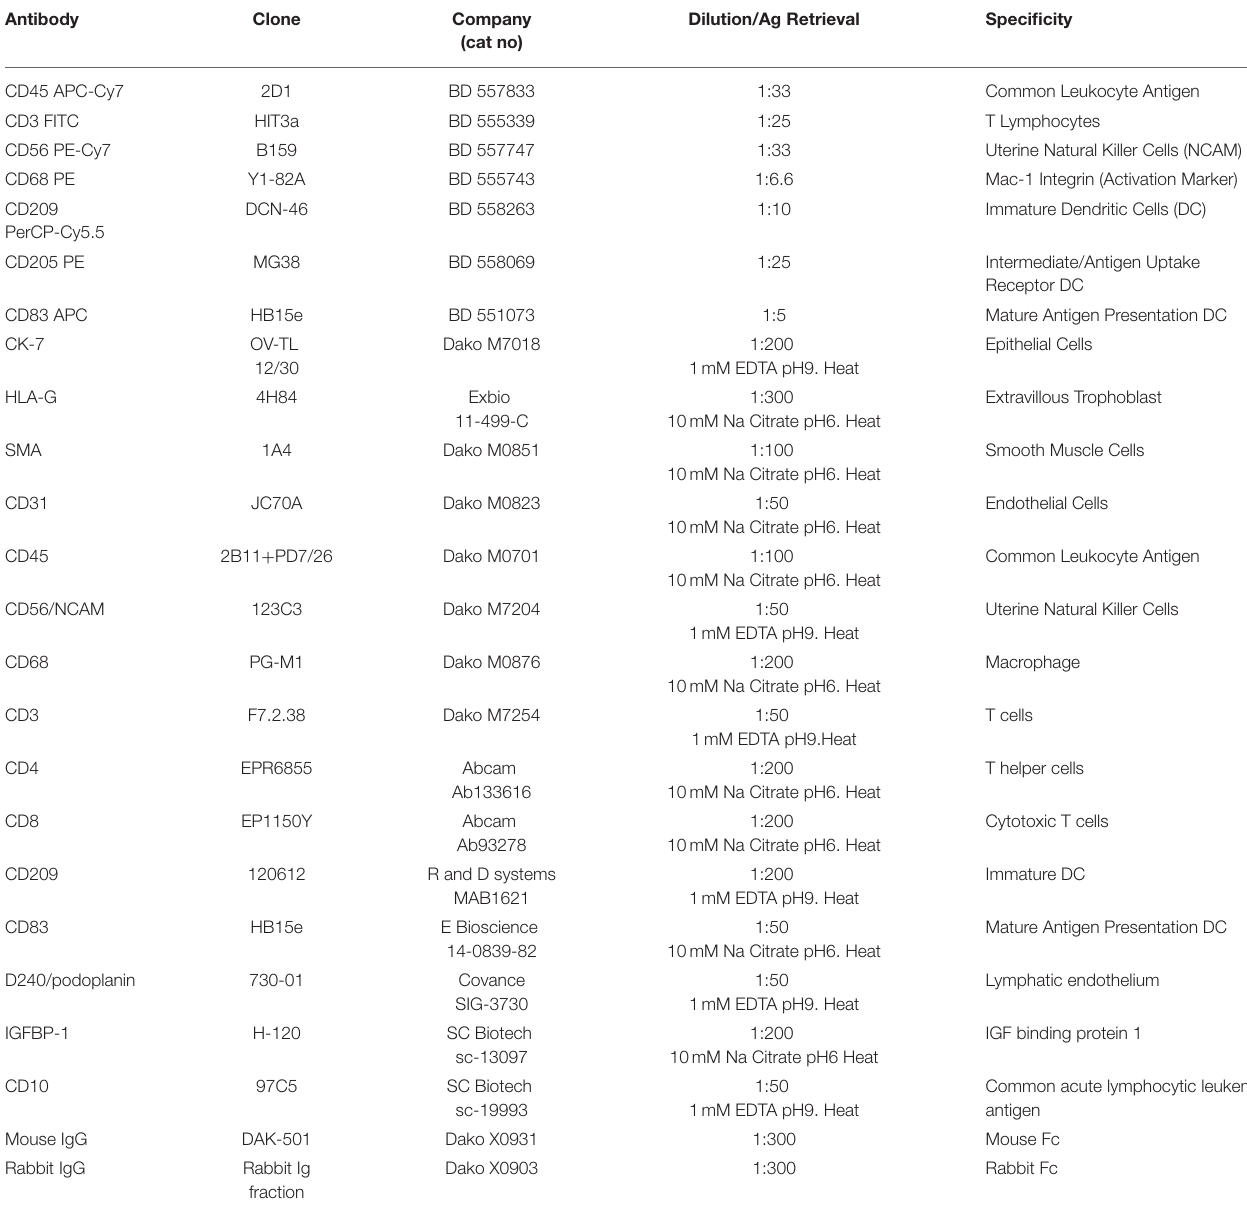
TABLE 4 | Flow cytometry and immunohistochemistry antibody information. Antibody Clone Company